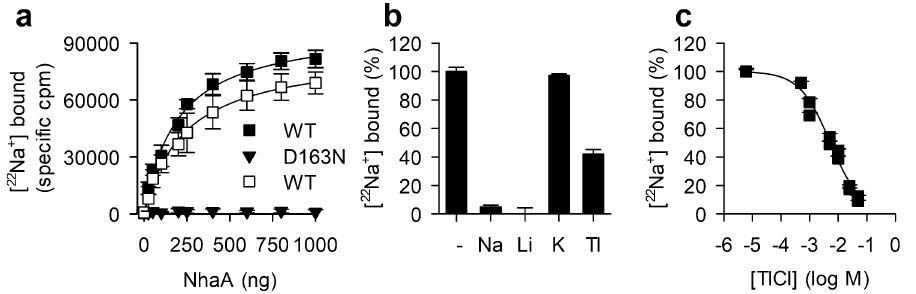
Figure 2. Ion binding by NhaA. ( a ) Optimization of the scintillation proximity assay (SPA) for 22 Na + binding by NhaA. PVT His-tag SPA beads were resuspended in the SPA assay buffer (200 mM Tris-Mes pH 8.0, 20% glycerol, 0.1 mM TCEP plus the indicated concentrations of DDM and/or cardiolipin) at a final concentration of 1.25 mg/mL. Binding of 50 µM [ 22 Na]Cl (50 Ci mol −1 ) was performed for 30 min with the indicated amounts of affinity-purified His-tagged NhaA at 23 °C before determination of the counts-per-minute (cpm) in the SPA mode of the MicroBeta 1450 microplate reader. The non-proximity (background) signal was determined by performing the reaction in the presence of 800 mM imidazole which competes with the His-tagged protein for binding to the His-tag SPA beads. Binding was tested for NhaA-WT in assay buffer that contained either 0.1% (w/v) DDM (open square) or 0.015% (w/v) DDM and 5% (w/v) cardiolipin (filled square). Binding was also tested for NhaA-D163N in the presence of 0.015% (w/v) DDM and 5% (w/v) cardiolipin (filled inverted triangle). Data of three independent experiments (represented as mean ± s.e.m.) were subjected to global nonlinear regression fitting in Prism 8 to obtain the total binding values ( B max ) (85,570 ± 2,528 specific cpm for NhaA-WT in 0.1% DDM and 98,980 ± 2,992 specific cpm for NhaA-WT in 0.015% DDM and 5% cardiolipin, respectively) and EA 50 (effective amount of NhaA at 50% B max ) of 236.2 ± 19.71 ng and 193.9 ± 17.87 ng, respectively. All subsequent experiments were performed in the presence of 200 ng of NhaA, the protein amount 50 µM [ 22 Na]Cl (50 Ci mol −1 ) to 200 ng of NhaA-WT was performed in the presence or absence of 10 mM